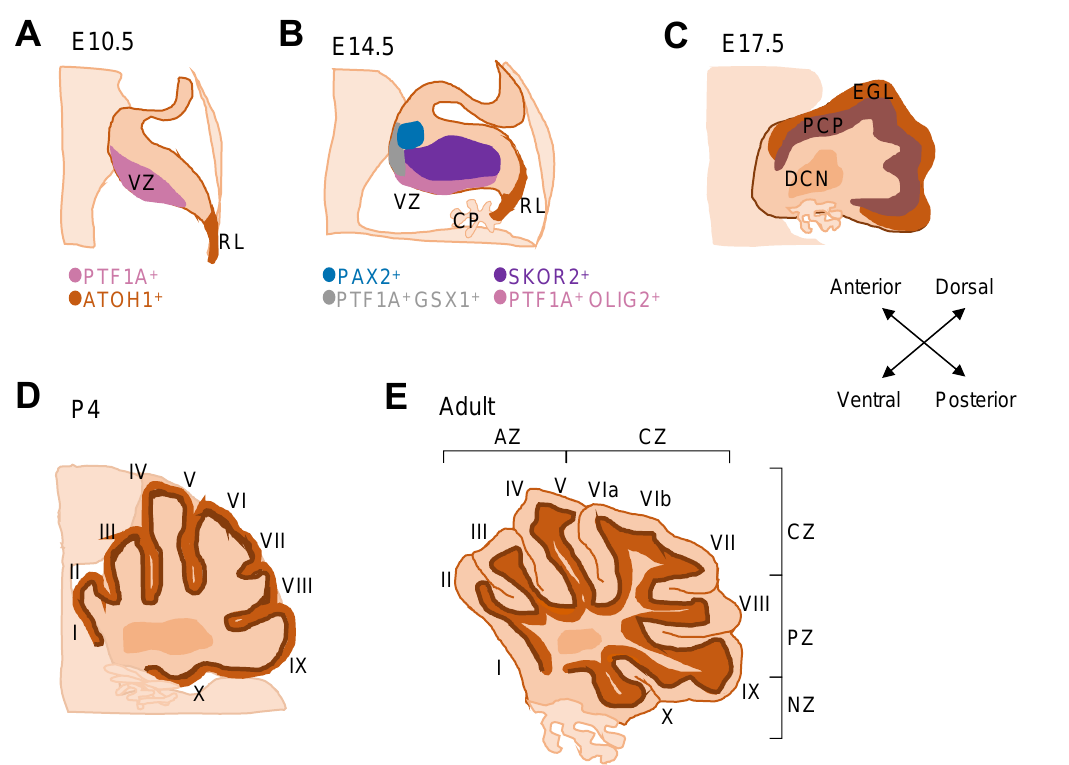
Figure 1. Schematic of mouse cerebellar development. Mid-sagittal sections show the stages of mouse cerebellar development over time from E10.5 to adult. ( A ) At E10.5, two germinal zones are established: the VZ and the RL, which are identified by expression of PTF1A and ATOH1, respectively. ( B ) SKOR2+ post-mitotic Purkinje cells are generated from PTF1A+ OLIG2+ progenitors in the VZ. The VZ also gives rise to PAX2+ interneurons from PTF1A+ GSX1+ progenitors. ( C ) From E14.5, Purkinje cells migrate outwards from the VZ to form the PCP. The PCP is initially several layers of cells thick and lies underneath the appearing EGL. ( D ) In early postnatal stages, the PCP spreads to form the characteristic monolayer of Purkinje cells that exists in the adult. ( E ) The adult cerebellum consists of ten lobules (I–X) from anterior to posterior that are grouped into four transverse zones. The cerebellar cortex has three layers, from the outside: molecular layer, Purkinje cell layer, granule cell layer. AZ, anterior zone; CP, choroid plexus; CZ, central zone; DCN, deep cerebellar nuclei; E, embryonic day; EGL, external granule layer; NZ, nodular zone; P, postnatal day; PCP, Purkinje cell plate; PZ, posterior zone; RL, rhombic lip; VZ, ventricular zone.